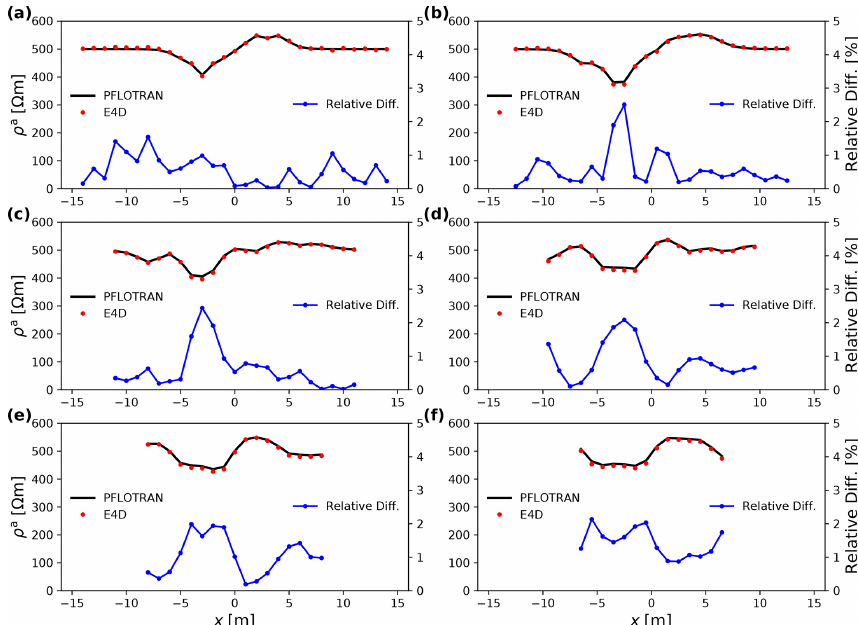
Figure 6. Apparent resistivity ρ a responses computed for the 3D earth resistivity model in Fig. 5 using the Wenner configuration with spac- ings: (a) a = 1m, (b) a = 2m, (c) a = 3m, (d) a = 4m, (e) a = 5m, and (f) a = 6m (upper plots). They are calculated using PFLOTRAN (solid black lines) and E4D (filled red circles) for an ERT profiling along a survey profile at y = z = 0 from x = − 16m to x = 16m. The lower plots (blue lines) show the relative difference (in percentage) between PFLOTRAN and E4D results.